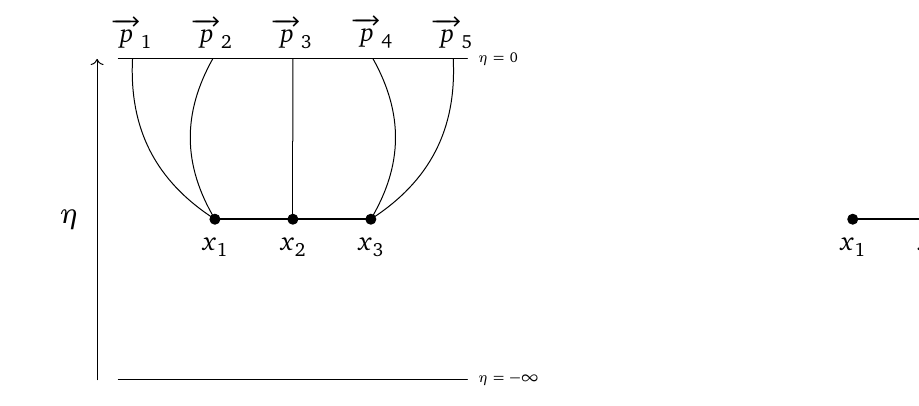
Figure 1: From Feynman to reduced graphs. A Feynman graphs (on the left) that contributes to the wavefunction of the universe, can be mapped into a reduced graph (on the right) by suppressing its external edges [ 34 ]